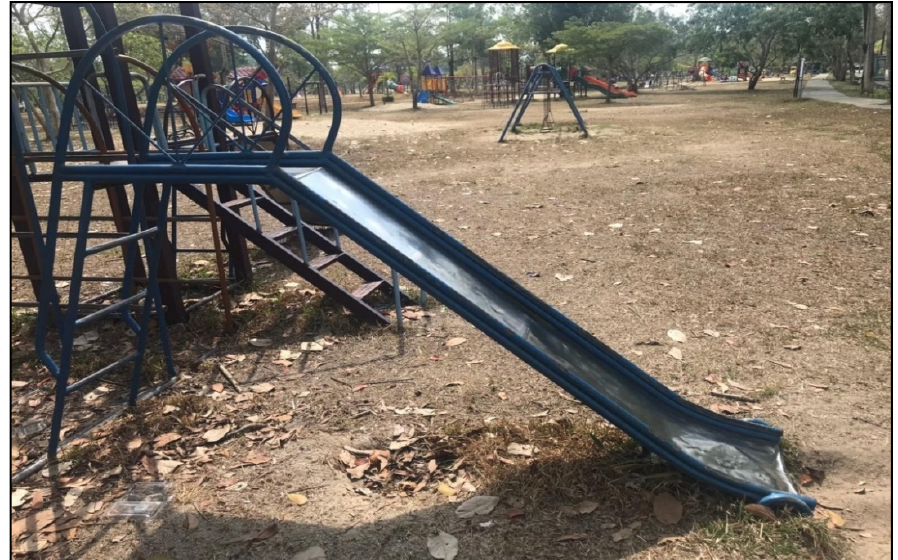
Figure 2. Slide set: There was no elevated area and no space to stand for some slides. The slide surface was rough and rusty. The sides of the slide had raised edges less than 10 cm high. There was no exit that was parallel to the floor. The length of the exit was not related to the length of the slide and the height between the floors to the exit.